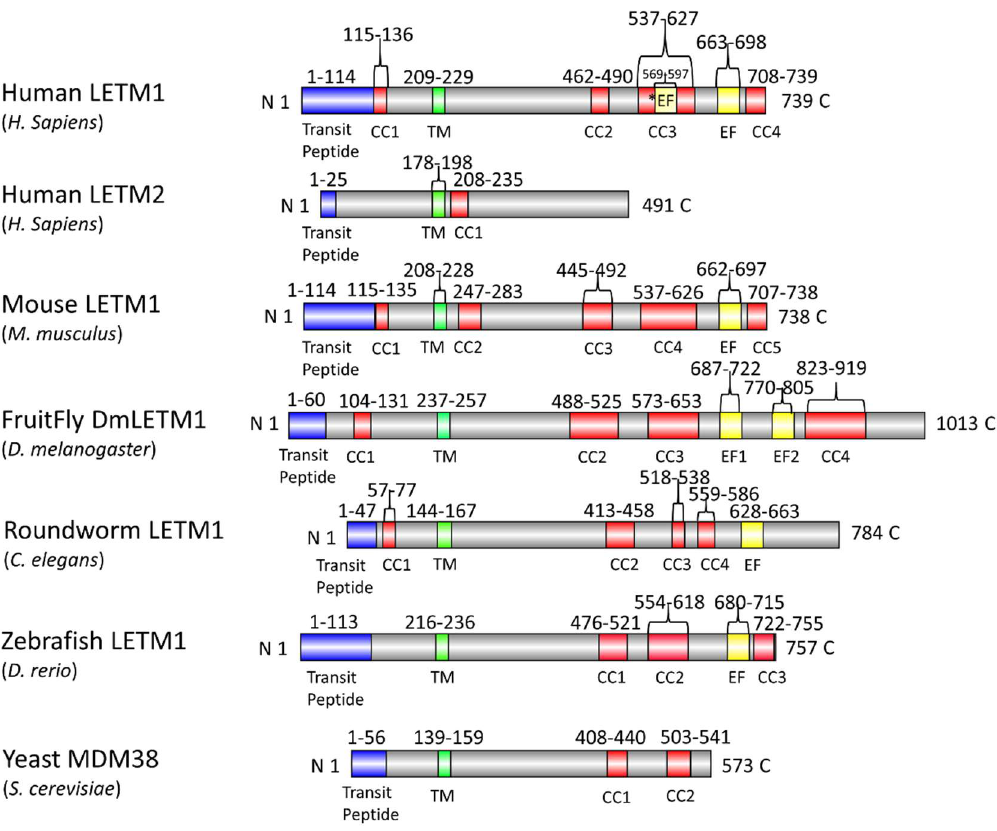
Figure 1. Predicted domain architecture of full length leucine zipper EF-hand containing transmembrane protein-1 (LETM1) orthologs in higher and lower order organisms. The N-terminal regions (upstream of the transmembrane domain) reside within the mitochondrial intermembrane space (IMS). The C-terminal regions (downstream of the transmembrane domain) reside in the mitochondrial matrix. Coiled-coils are denoted with CCn (red; where n identifies sequential domain numbers), EF-hand motifs are denoted with EFn (yellow; where *EF denotes the putative non-canonical EF-hand motif reported in the literature [65,70]), and transmembrane domains are denoted with TM (green). The regions corresponding to the transit peptides are shaded blue. Numbers above each domain correspond to the residue ranges defining each domain. The amino and carboxyl termini are denoted by N and C, respectively. The relative location of each domain is based on the UniProt annotations. The UniProt accession numbers for the D. rerio (zebrafish), M. musculus (mouse), D. melanogaster (fruitfly), C. elegans (roundworm), S. cerevisae (yeast) and H. sapiens (human) LETM1 orthologs are Q1LY46, Q9Z2I0, P91927, Q9XVM0, Q08179 and O95202, respectively. The UniProt accession number for the H. sapiens (human) LETM2 protein is Q2VYF4.